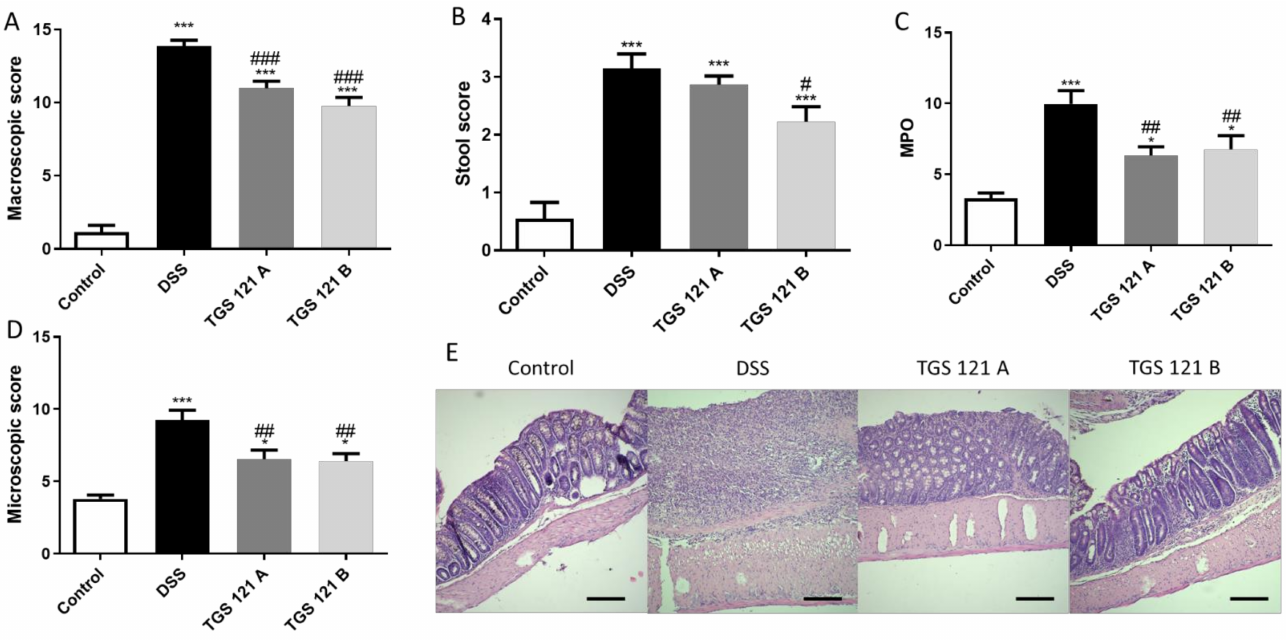
Figure 2. The effect of TGS 121 on colonic inflammation in a dextran sulphate sodium (DSS)-induced model of colitis: macroscopic score ( A ), stool score ( B ), myeloperoxidase activity ( C ), and microscopic score ( D ) for control, DSS-only treated mice, and mice with DSS-induced colitis treated with TGS 121 in two doses: 1.68 µ g/kg (TGS 121 A) and 16.8 µ g/kg (TGS 121 B). Representative photos of hematoxylin and eosin staining of colon samples ( E ). Scale bar = 100 µ m. * p < 0.05 and *** p < 0.001 as compared with the control mice; # p < 0.05, ## p < 0.01, ### p < 0.001 as compared with DSS-treated